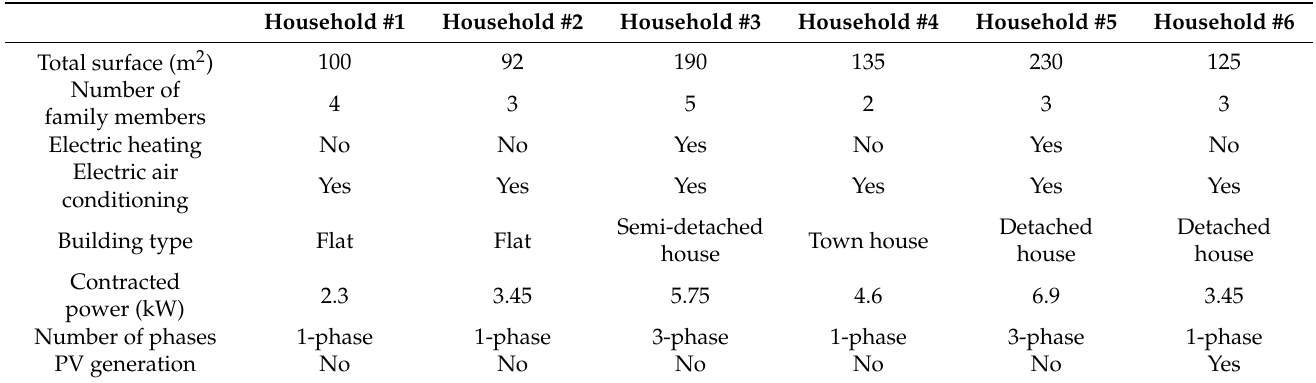
Table 7. Configuration of the five households